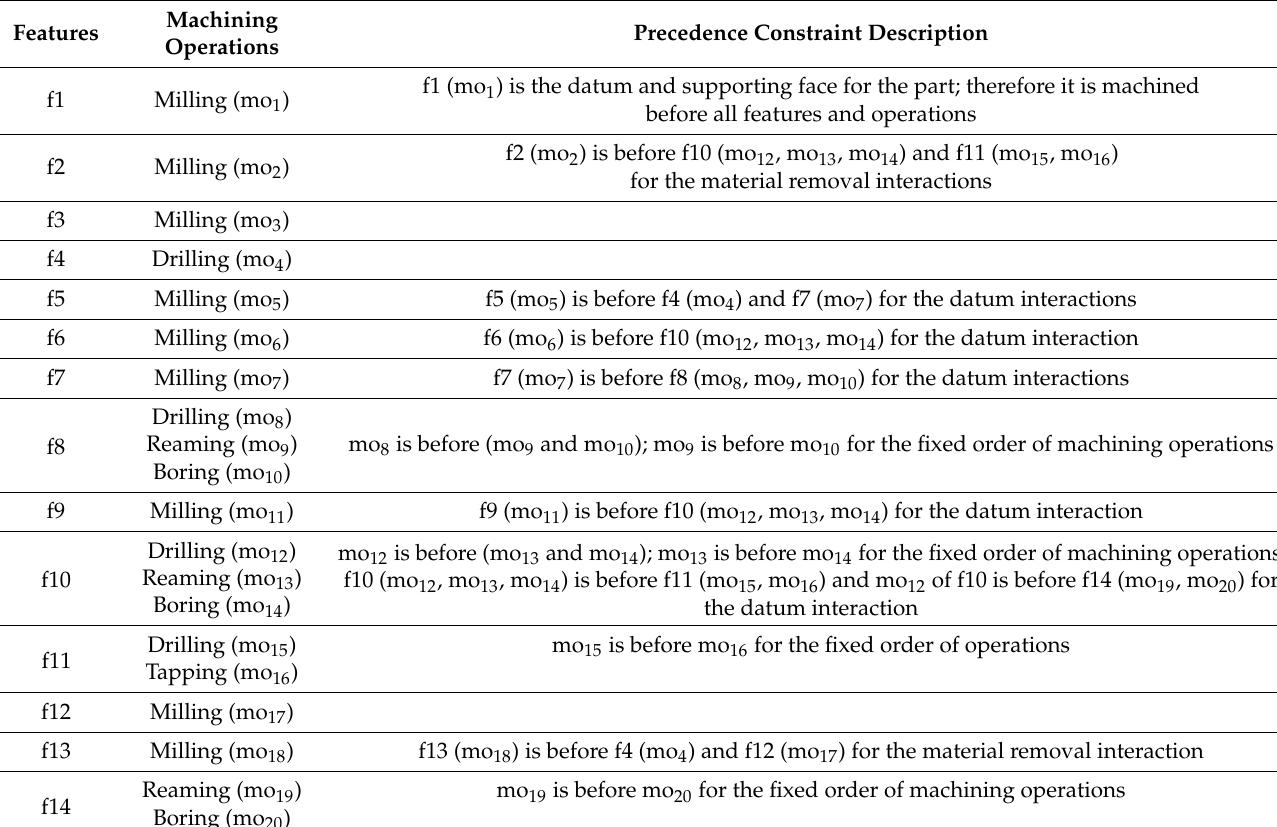
Table 2. Precedence relationships for prismatic part 1.